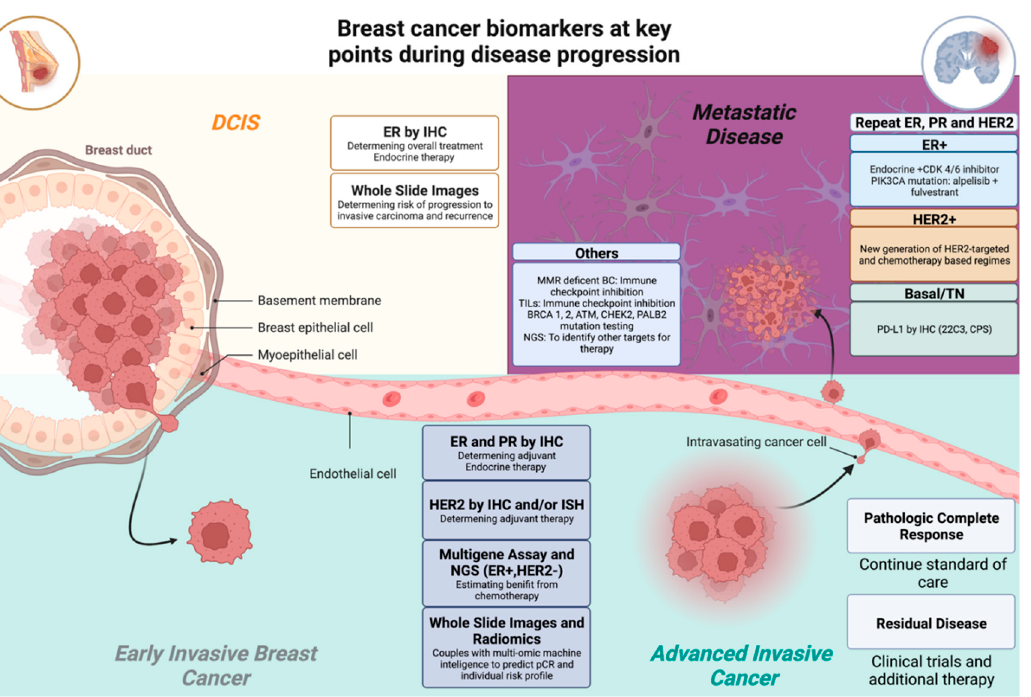
Figure 1. Breast cancer biomarkers at key points during disease progression. Adapted from the fol- lowing references [10–14].